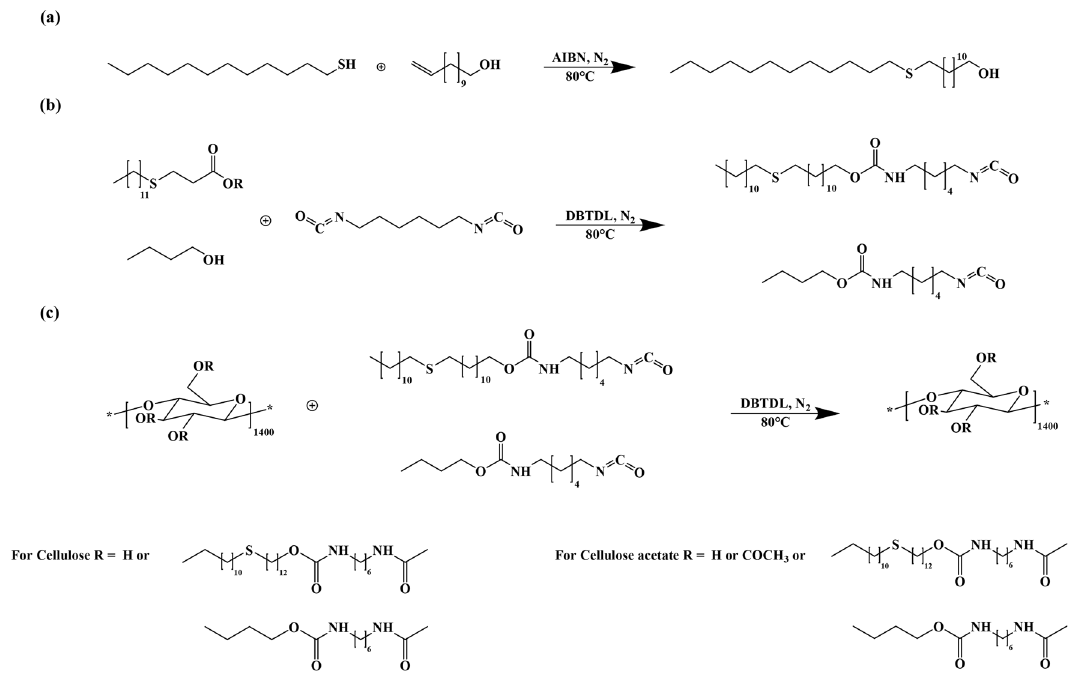
Figure 1. Synthesis of the: ( a ) telomere (R-S-R ′ -OH), ( b ) precursors (HDI-OH-RSR’ and HDI-but-OH), and ( c ) of Cell-P 1 , Cell-P 2, CA-P 1 and CA-P 2